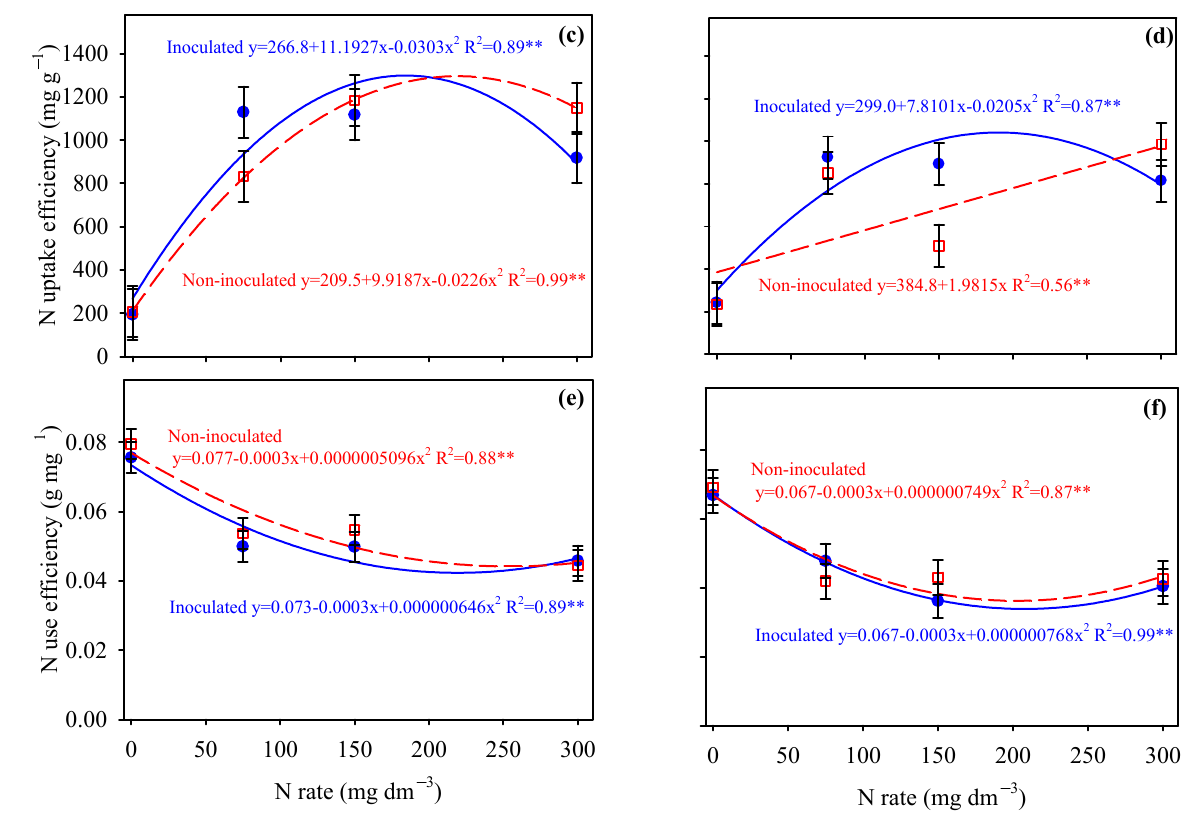
Figure 4. Amount of N accumulated in the whole plant ( a , b ), N-uptake efficiency ( c , d ), and N-use efficiency ( e , f ) of potato in response to N application rates and A. brasilense inoculation in natural and disinfected soil. Bars represent the least significant difference between A. brasilense inoculation in the same N rate at p < 0.05 according to the LSD test. ** p < 0.01. The amount of N accumulated in the cassava plants in the natural soil increased significantly up to 50 mg dm − 3 N in the inoculated plants, and up to 152 mg dm − 3 N in the non-inoculated plants (Figure 5a). At a rate of 50 mg dm − 3 N, the inoculated cassava plants accumulated 19% more N than the non-inoculated plants. In disinfected soil, the amount of N accumulated by cassava plants increased linearly with N fertilization in the non-inoculated plants, and up to an estimated rate of 163 mg dm − 3 N in the inoculated plants (Figure 5b). In the disinfected soil, A. brasilense inoculation increased the amount of N accumulated by plants by 27–40% in all treatments with mineral N supply. Natural soil